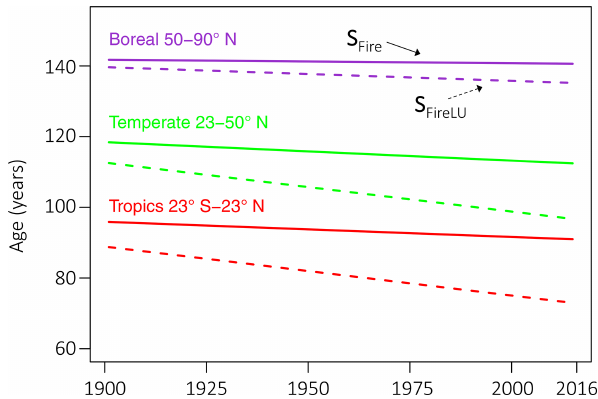
Figure 9. Trend in ecosystem age by zonal band for LPJ-wsl v2.0 simulation with only fire ( S Fire , solid lines) and with both fire and LUCLM ( S FireLU , dashed lines). Fire causes zonal bands to dif- fer in ecosystem age by ∼ 23 years and decreases the average age by 0.009 to 0.054yr − 1 . LUCLM decreased ecosystem age at rates up to 3 times the rate of fire, from 0.038yr − 1 in boreal zones to 0.138yr − 1 in temperate and tropical